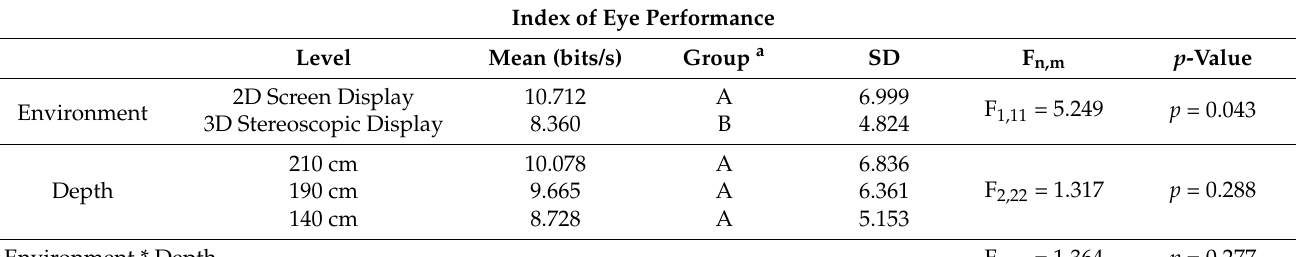
Table 4. Means, SDs, ANOVA, and Tukey HSD test results of eye